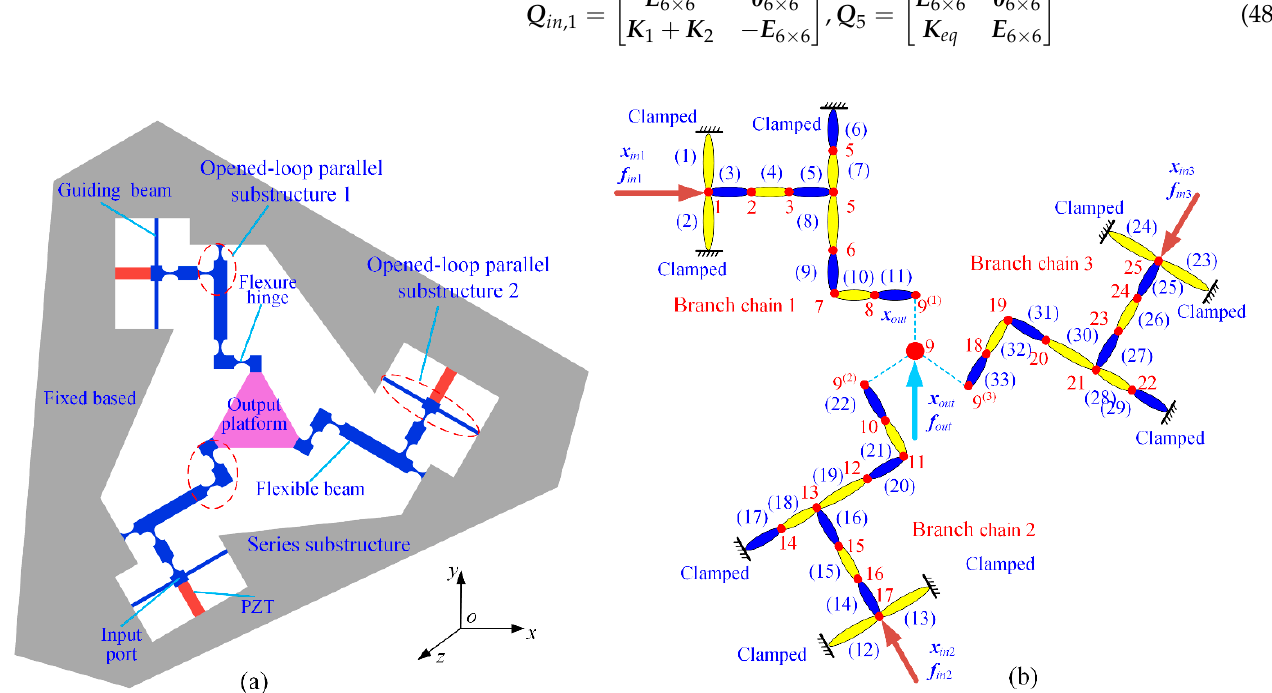
Figure 13. The 3-DOF precision positioning platform: ( a ) schematic; ( b ) discretization and numbering. By performing rotation transformation, the transfer matrices of branch chains (2)